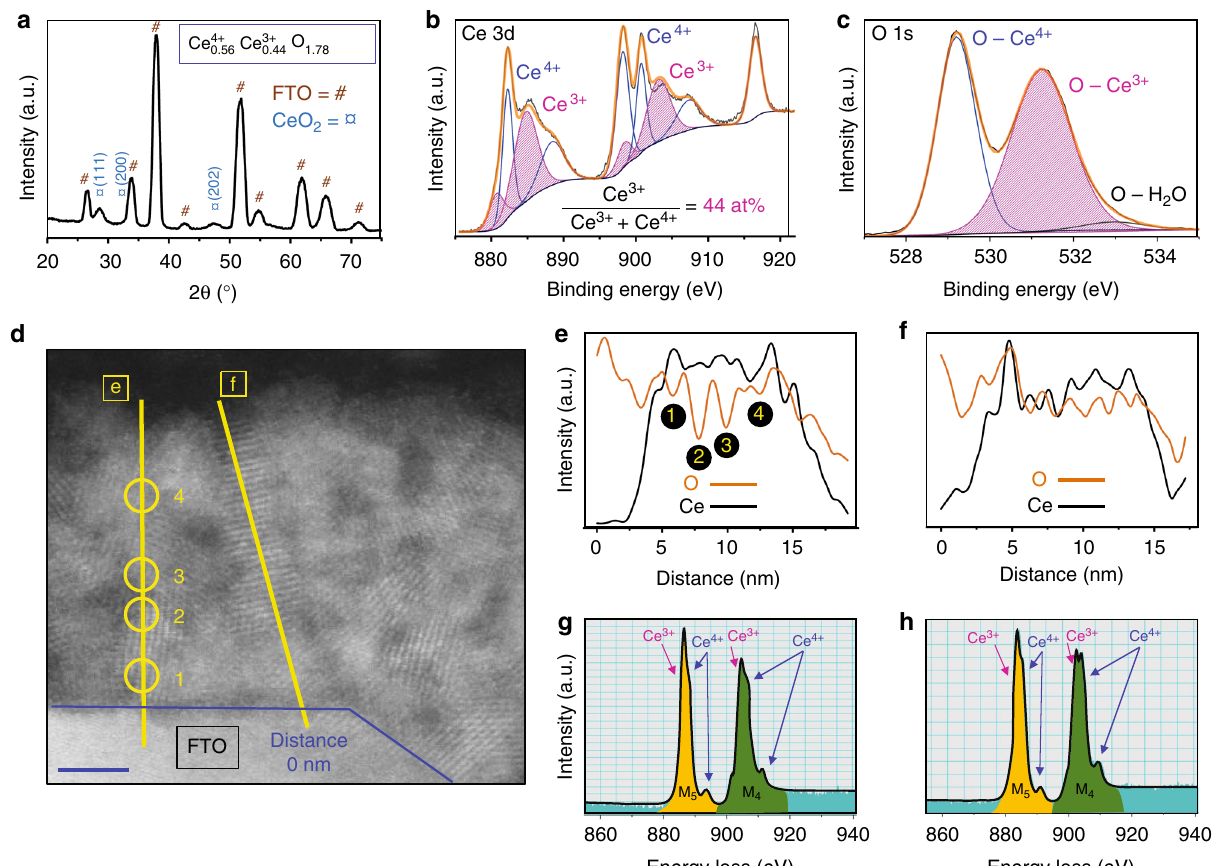
Fig. 1 Characterisation of CeO 2 − x thin fi lms. a Representative XRD pattern of a CeO 2 − x fi lm deposited at a scan rate of 3000 mV s -1 for 1000 cycles. b XPS spectrum for Ce 3 d orbital. c XPS spectrum for O 1 s orbital. d HAADF image of nanostructure (scale bar is 2 nm). e EDS line scan across crystallite boundaries (left). f EDS line scan within crystallite (right). g EELS spectrum at crystallite boundary (point g). h EELS spectrum within crystallite (point